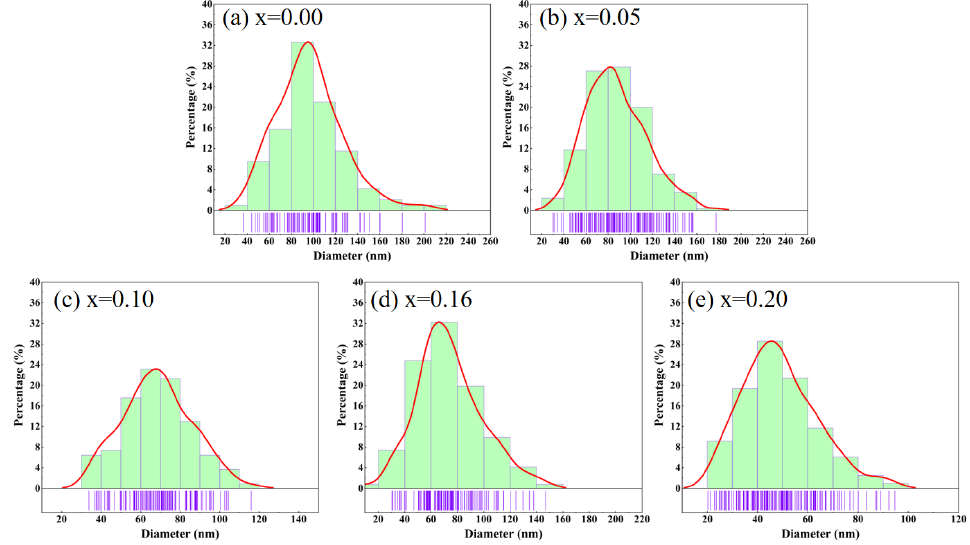
Figure 3. Histograms for particle size distribution and Gaussian fitting curve of ( a – e ) BNFMO (x = 0.00, 0.05, 0.10, 0.16, 0.20) films.